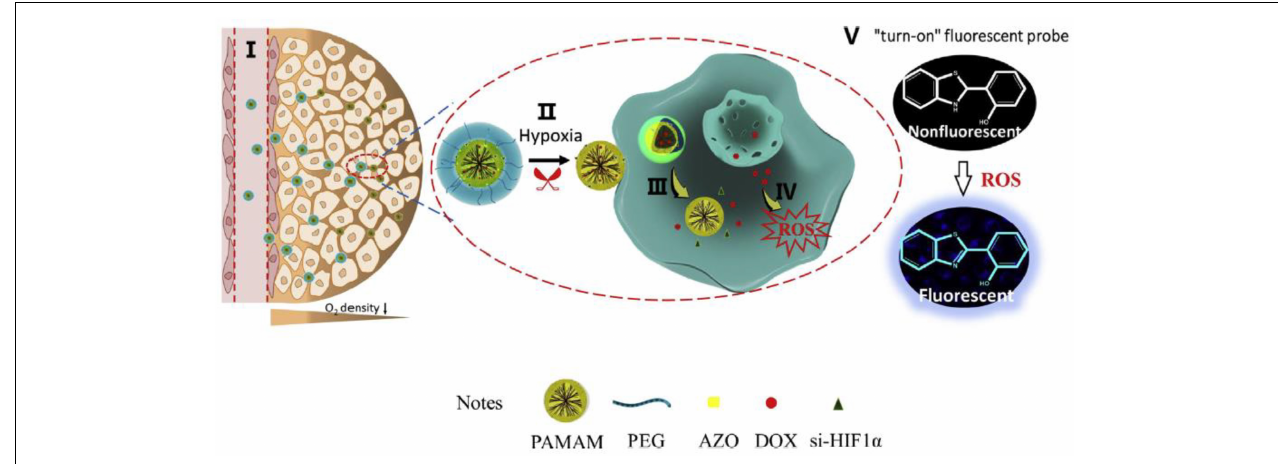
FIGURE 1 | Schematic illustration of the transport path for a hypoxia responsive size-shrinkable nanoparticle PEG-AZO-PAMAM (PAP) for co-delivery of doxorubicin, siRNA, and a ROS probe to increase penetration into tumor. (I) Blood circulation: PAP was efficiently transported to the tumor site via long circulation time of PEG in blood and the EPR effects. (II) Tumor microenvironment: AZO was degraded in hypoxic tumor microenvironments, and PEG was removed to realize size shrinkage and expose positively charged PAMAM that help to penetrate into the tumor core. (III) Within the tumor cells: Through the proton pump effect, PAMAM escaped from endosomes to release DOX and siRNA. (IV) An increased level of ROS induced by DOX. (V) Fluorescence imaging: The elevated ROS level induced by DOX could trigger the “turn-on” of fluorescent probe (reproduced with permission from Xie et al. (2018). Copyright 2018